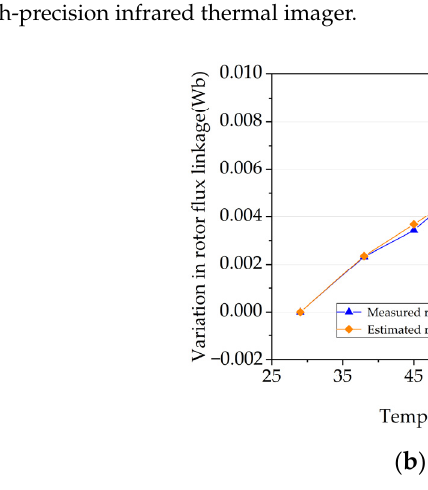
Figure 10. Comparison between estimated and measured rotor flux linkage under different PM temperatures. ( a ) Estimated/measured rotor flux linkage; ( b ) variation in the rotor flux linkage.